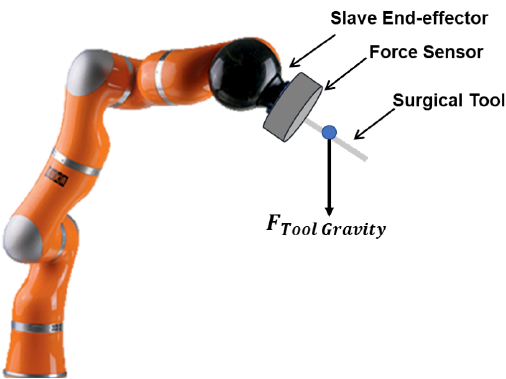
Figure 2. Force sensor installation. It is mounted at the end effector of the manipulator and a robot tool is attached on the force sensor.